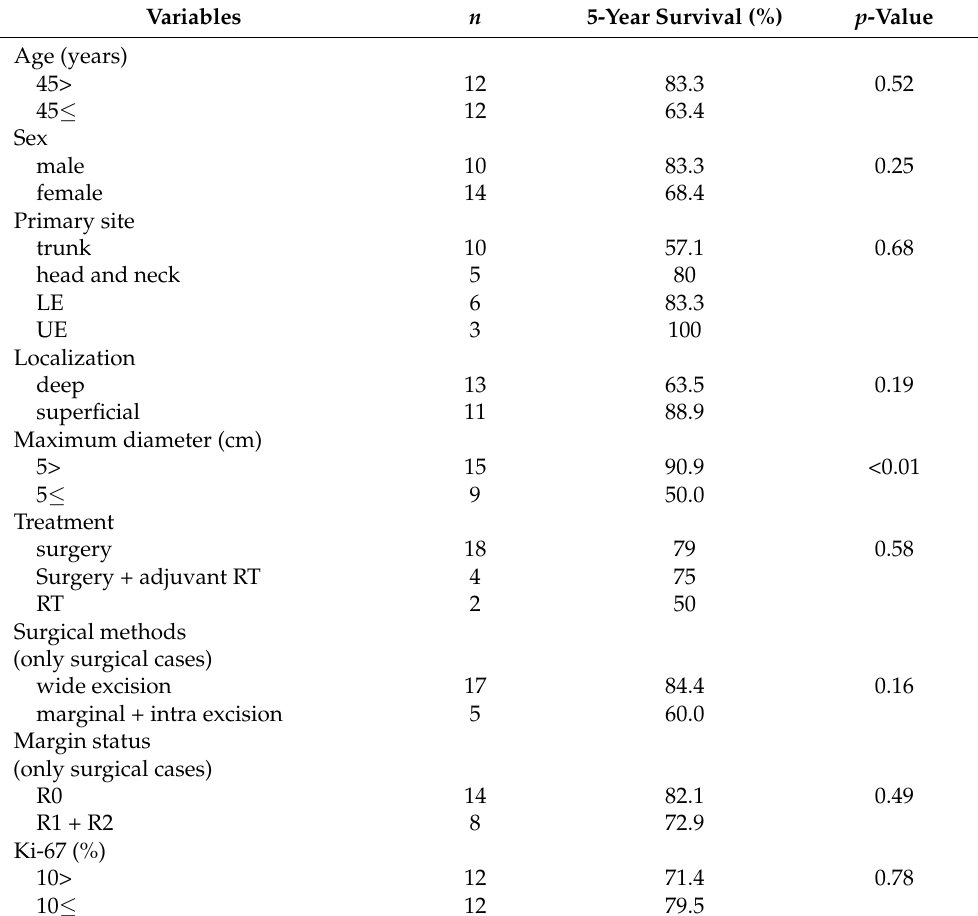
Table 3. Risk factors for local